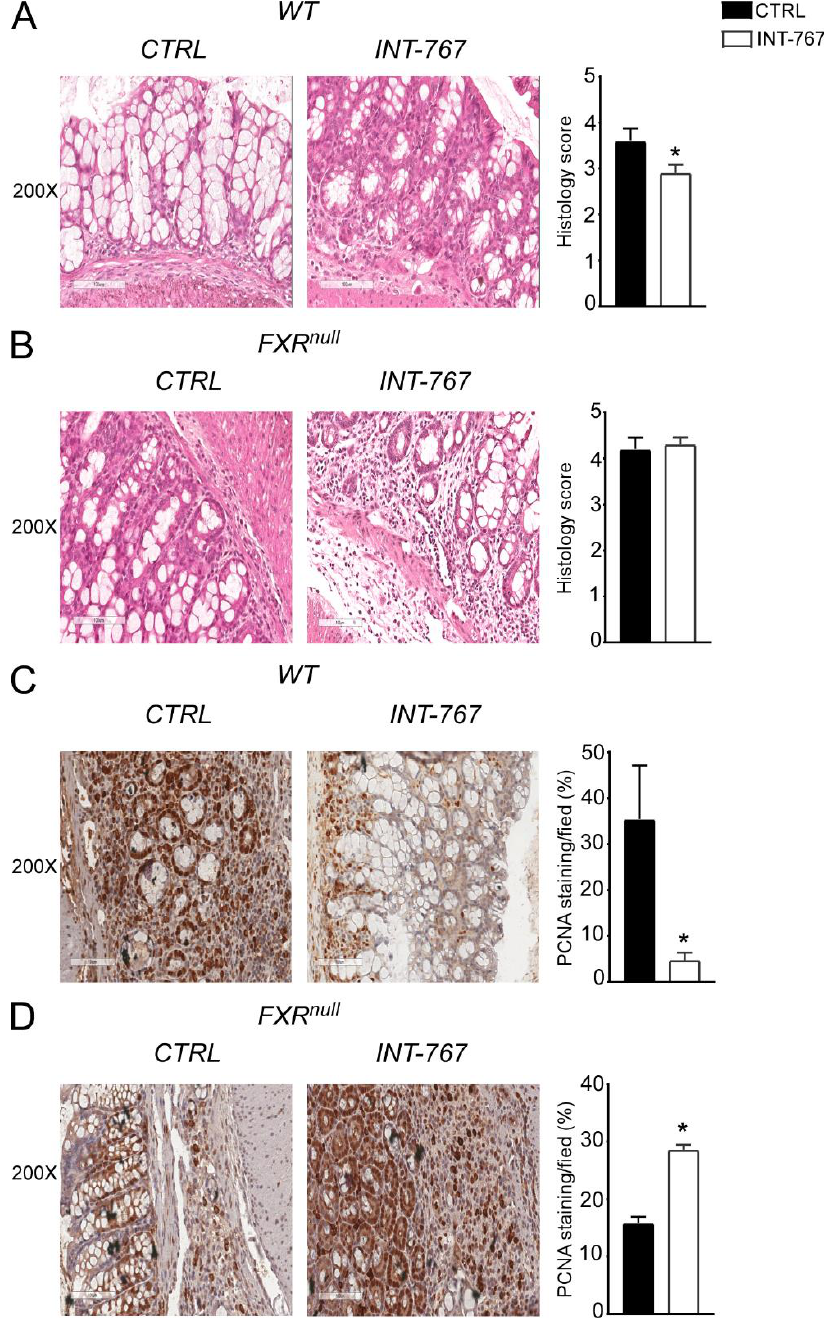
Figure 3. INT-767 protects from DSS-induced colitis. Histology of colonic specimens of ( A ) WT and ( B ) Fxr null mice fed with or without INT-767 was assessed by H&E staining and was observed by light microscopy (magnification, 200×; n = 5 WT CTRL and n = 5 WT INT-767; n = 5 Fxr null CTRL and n = 5 Fxr null INT-767). Representative specimens are shown. Histology score of inflammation was calculated using an established semiquantitative score ranging from 0 to 6 based on infiltration of inflammatory cells and epithelial damage. Paraffin-embedded tumor specimens from ( C ) WT and ( D ) Fxr null mice fed with or without INT-767were immunoassayed with anti-PCNA antibody (200× magnification; n = 5 WT CTRL and n = 5 WT INT-767; n = 5 Fxr null CTRL and n = 5 Fxr null INT-767). Representative specimens are shown. PCNA staining per field was quantified by ImageJ software and reported as percentage per field. Results are the mean±SEM. Statistical significance was assessed by Student’s t -test (* p < 0.05).